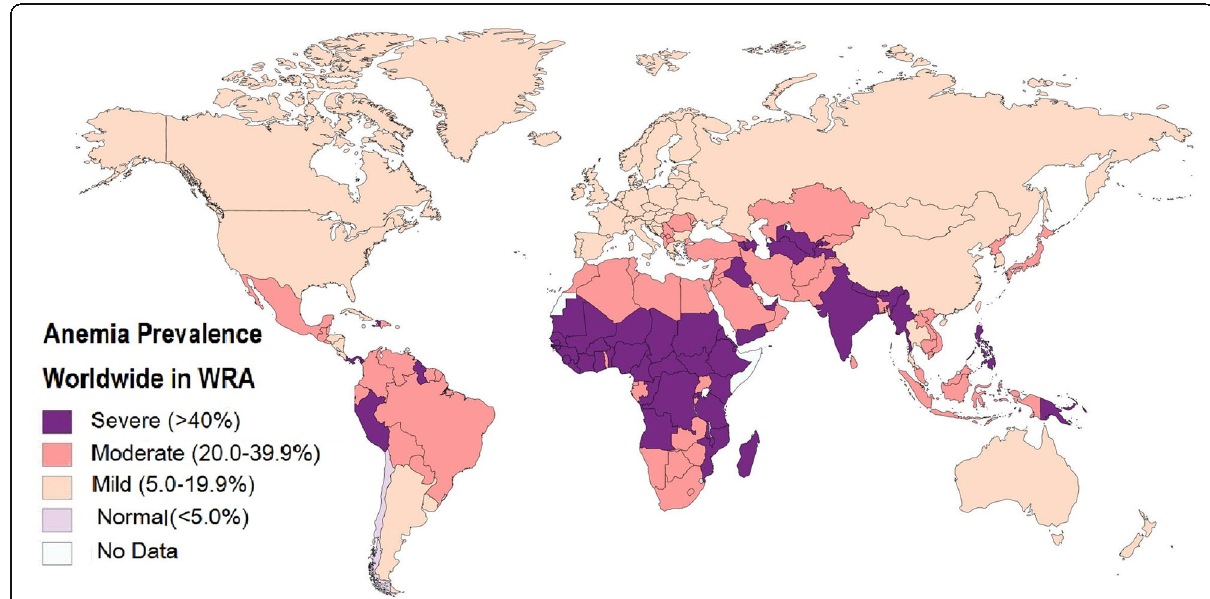
Fig. 1 Anemia prevalence worldwide in women of reproductive age. The highest prevalence is seen in Sub-Saharan Africa (SSA), Eastern Mediterranean, and South East Asia. The lowest prevalence is in the Americas. Data source: